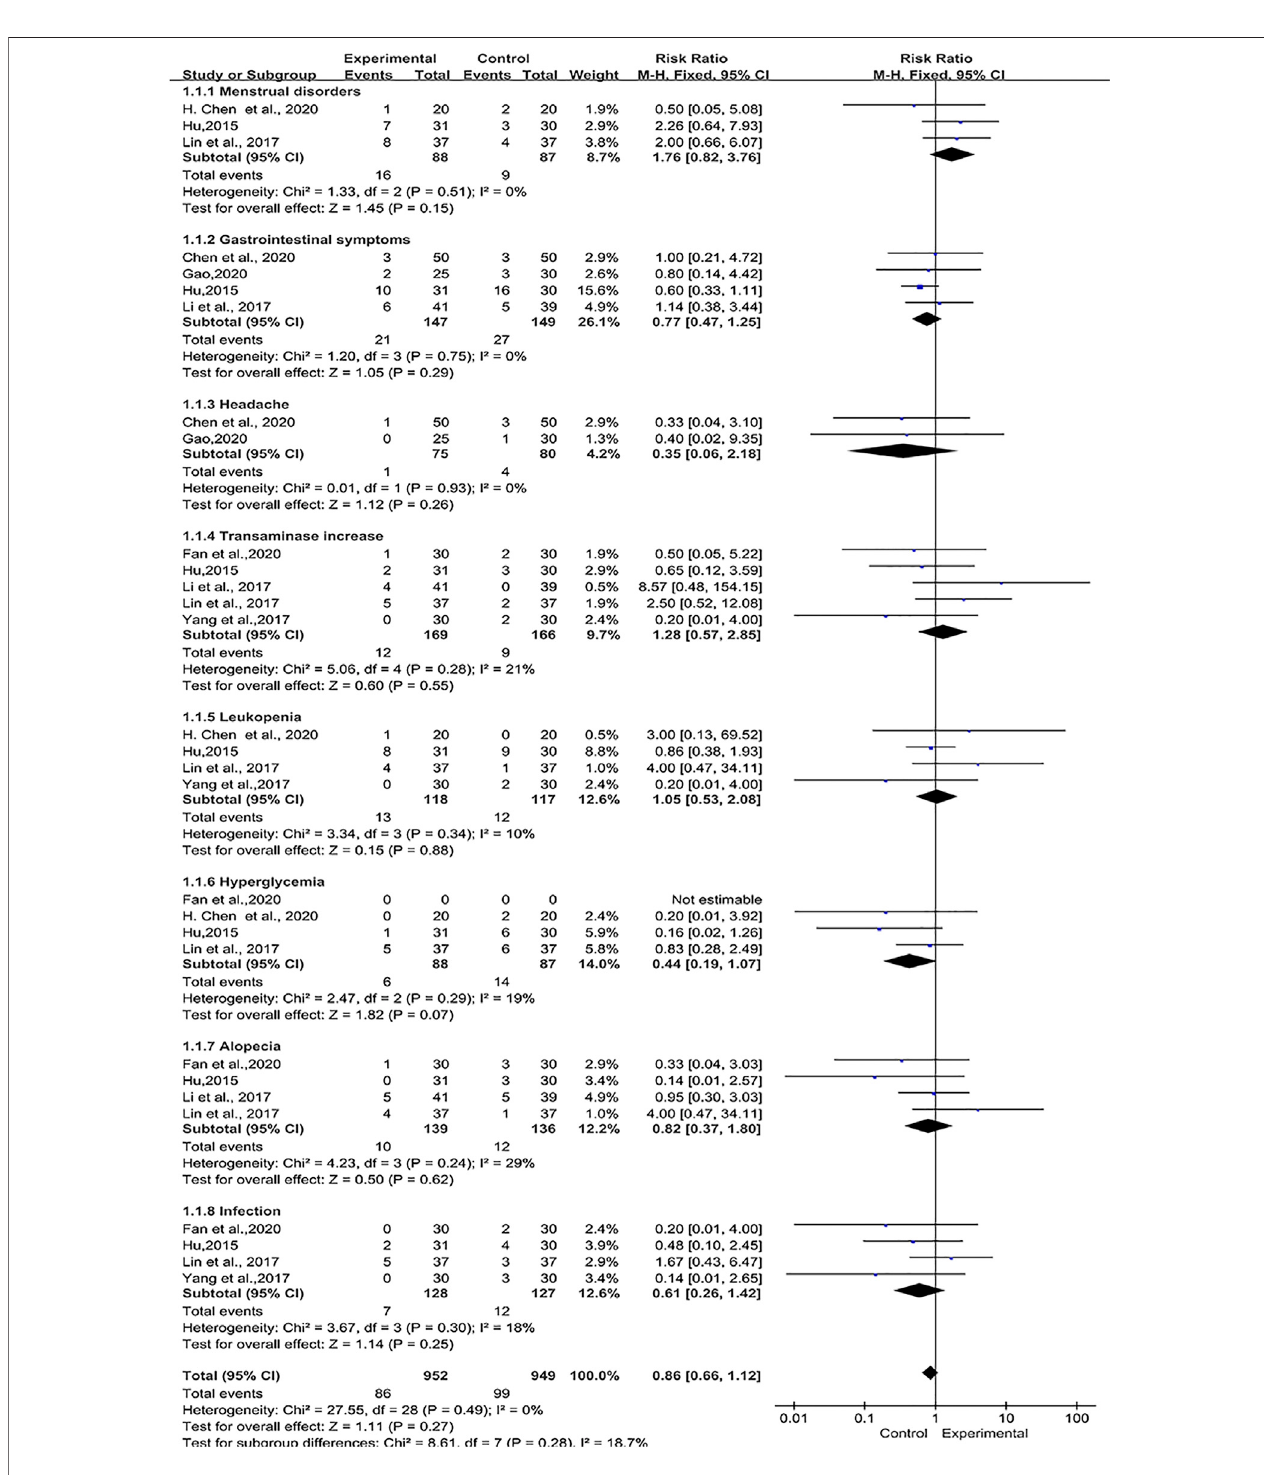
FIGURE 8 | Forest plot of adverse events with TwHF combined with conventional treatment versus pure conventional treatment.